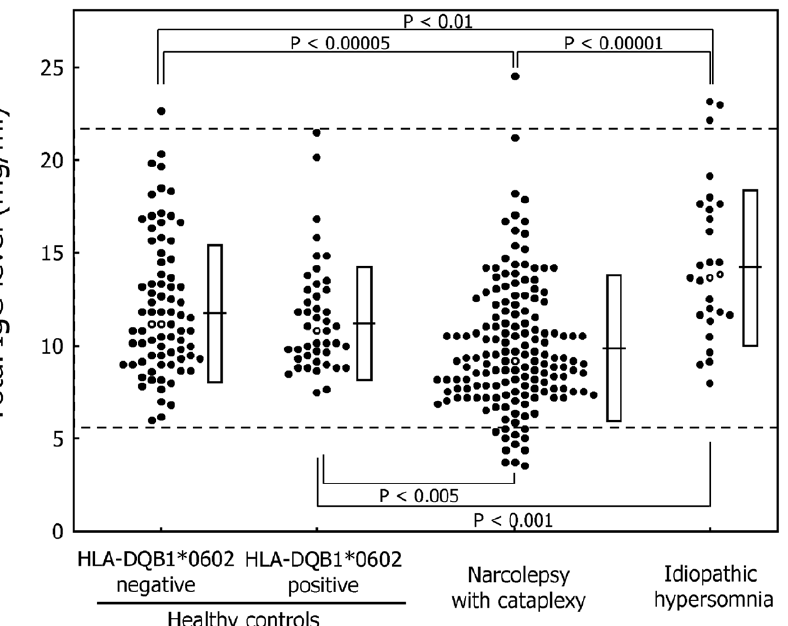
Figure 1. Serum total IgG level. Each dot corresponds to the serum IgG level (mg/ml) in each subject. Dotted lines indicate the normal range. The normal range is set at 5.5–22.0 mg/ml according to the manufacturer’s instructions. Horizontal lines and squares indicate the mean 6 SD of four groups. Outlined-dots indicate the median of four groups.